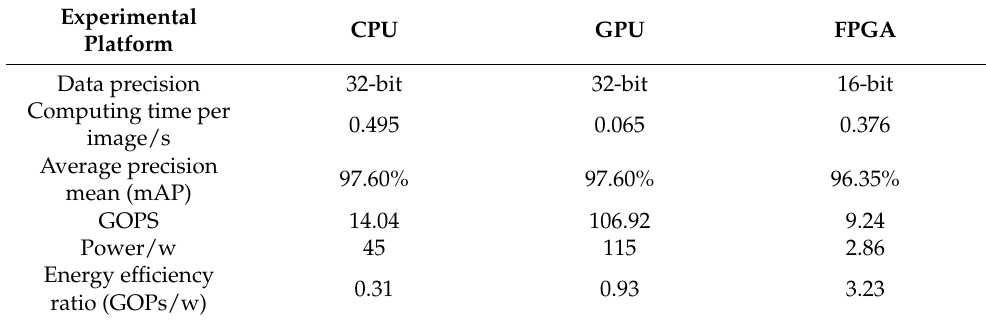
Table 3. Performance comparison results of the algorithm on the FPGA, CPU, and GPU platforms.